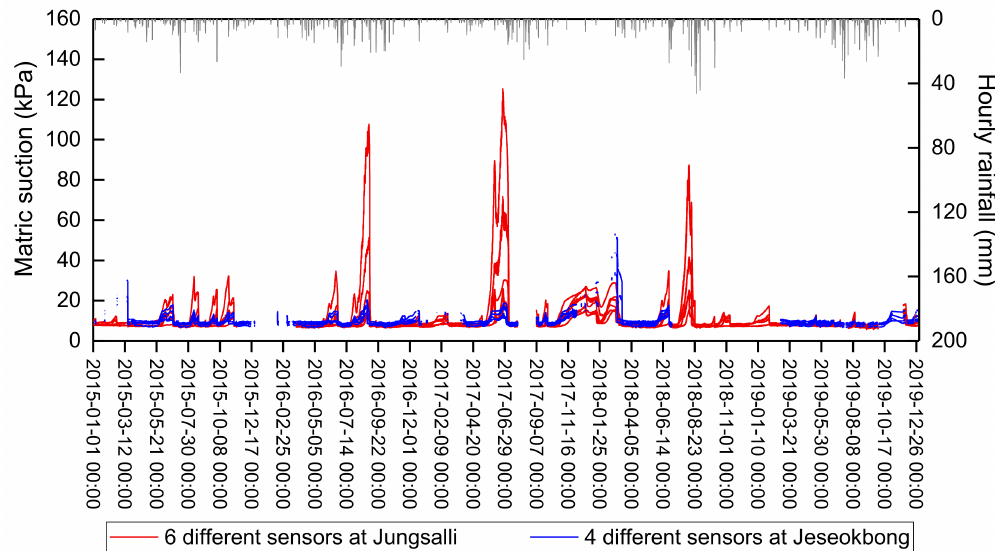
Figure 13. Monitored matric suction data of the Jeseokbong and Jungsalli